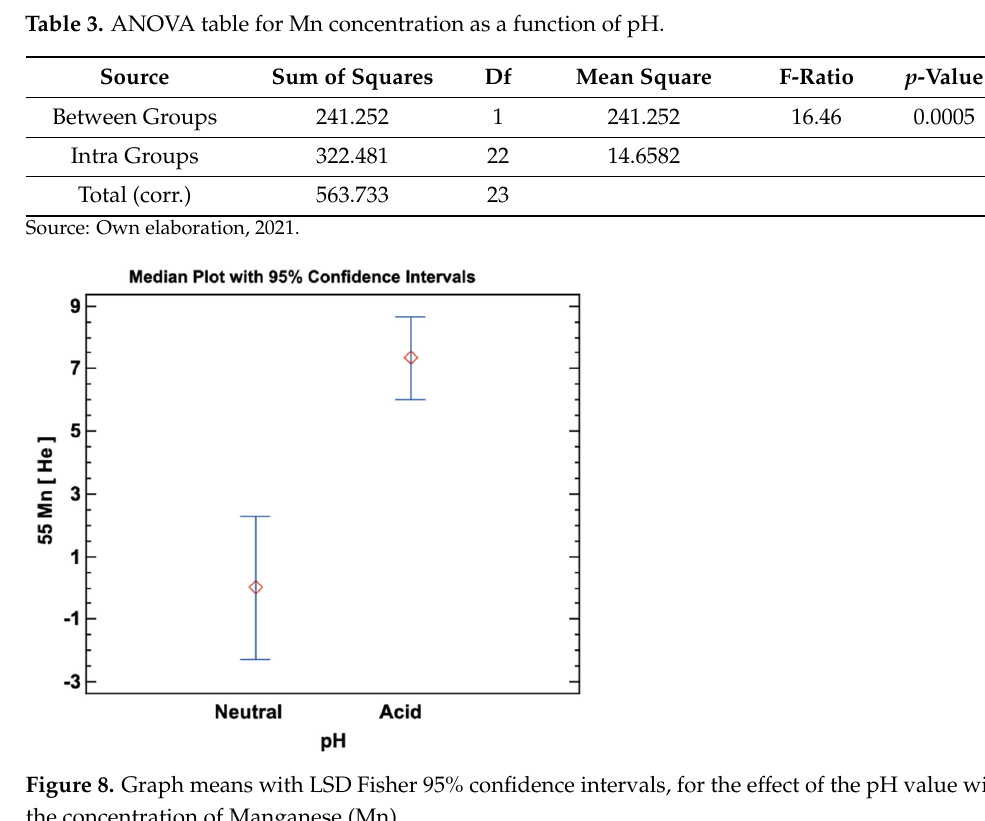
Table 3. ANOVA table for Mn concentration as a function of pH.